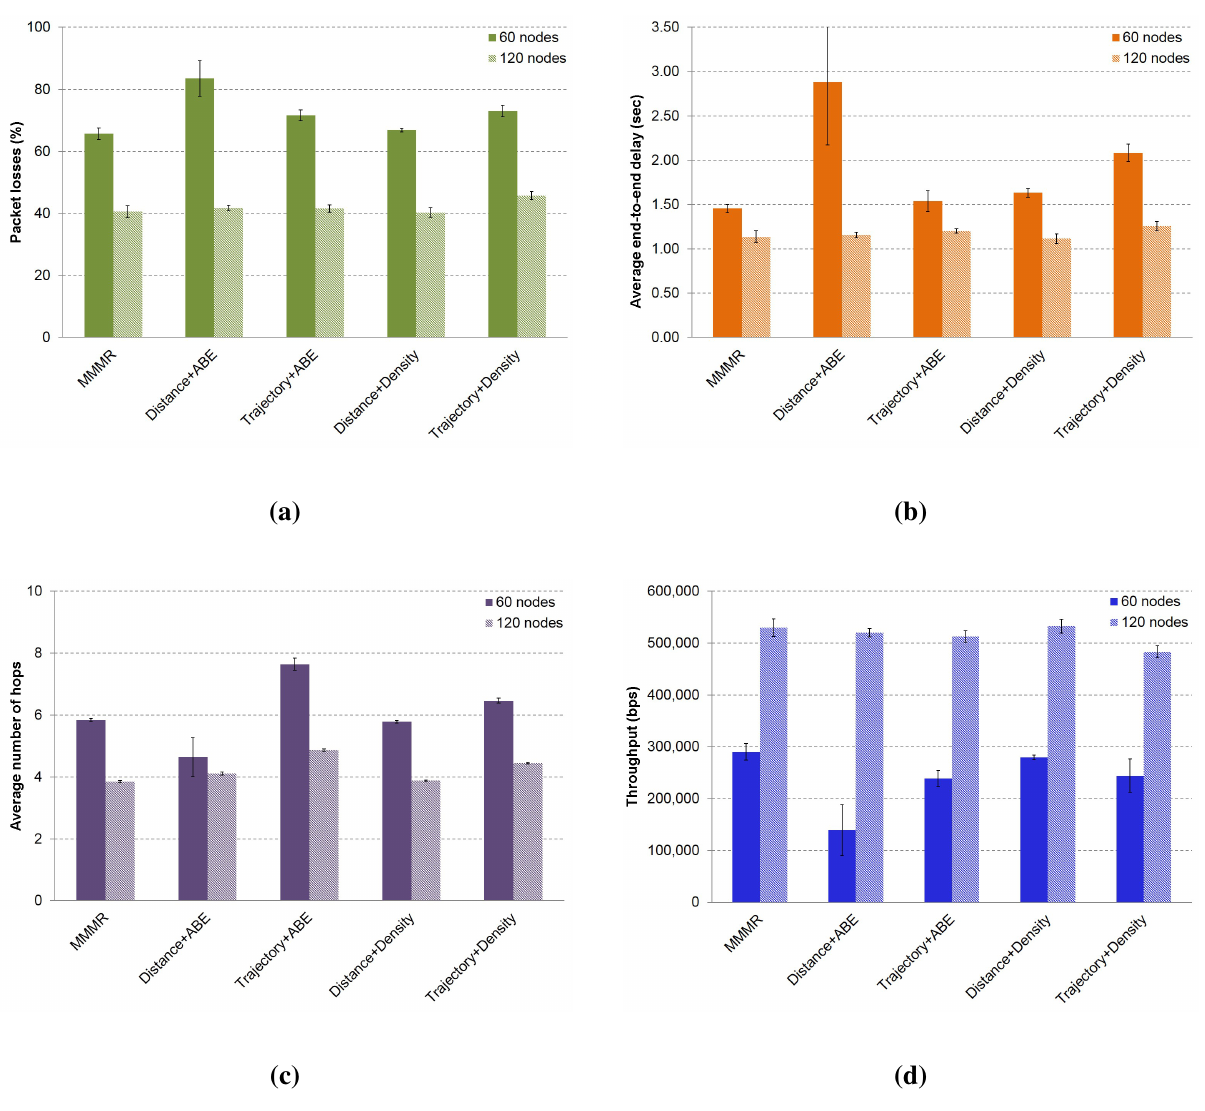
Figure 9. The performance of MMMR using four combination of metrics in low (60 nodes) and medium (120 nodes) density scenarios, compared to MMMR using the four metrics. The results show: ( a ) the percentage of packet losses; ( b ) the average packet delay; ( c ) the average number of hops to the destination; and ( d ) the throughput of the received packets (CI